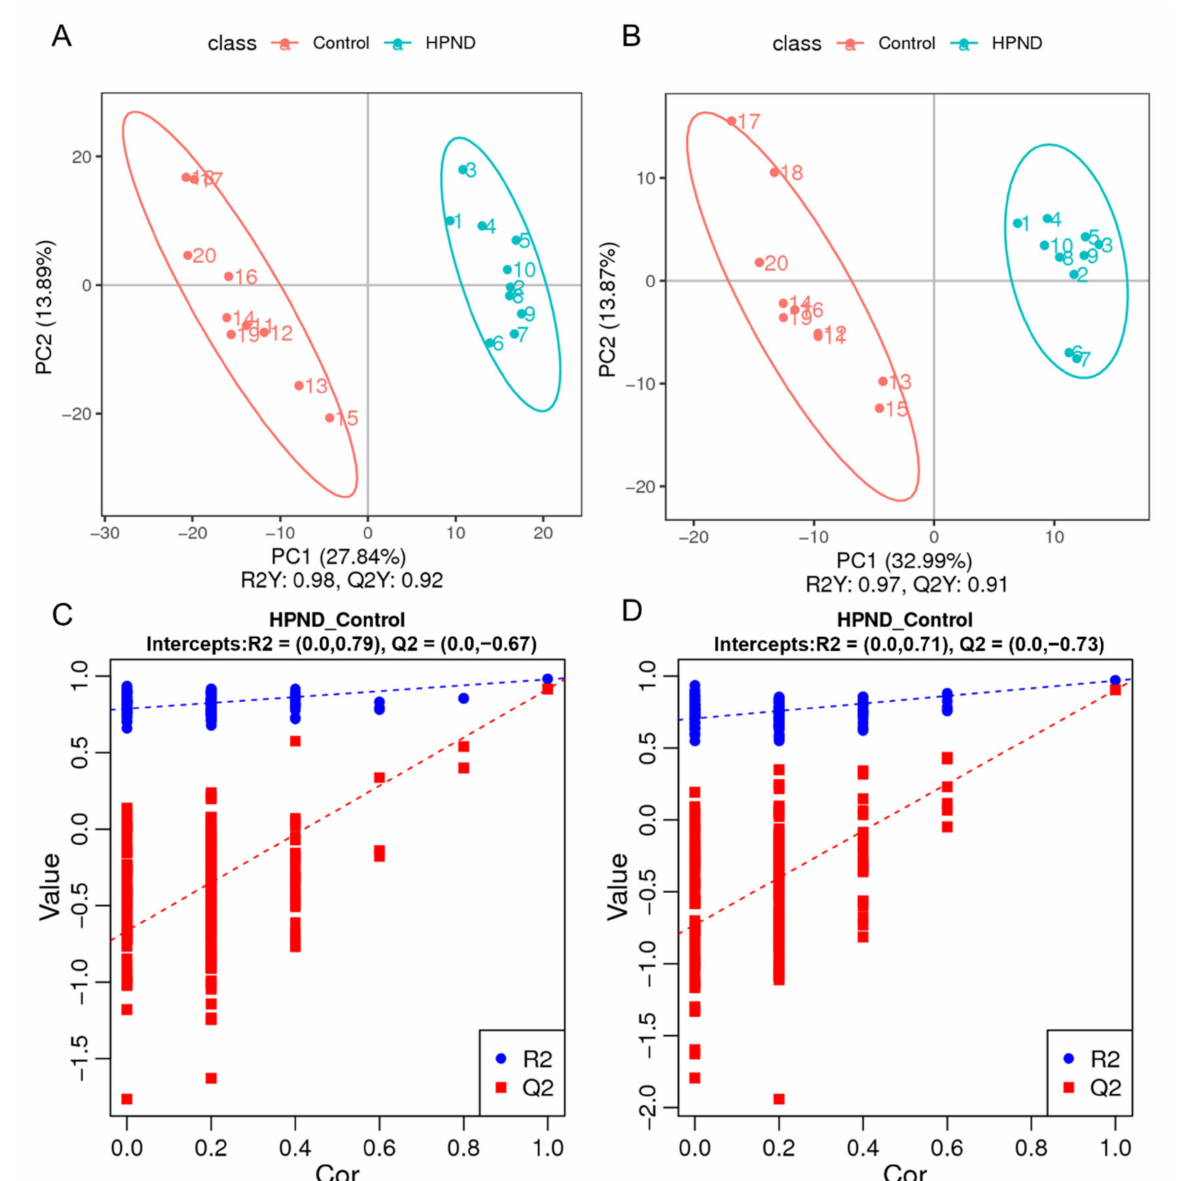
Figure 4. PLS-DA score plots in different groups (( A , C ) POS mode; ( B , D ) NEG